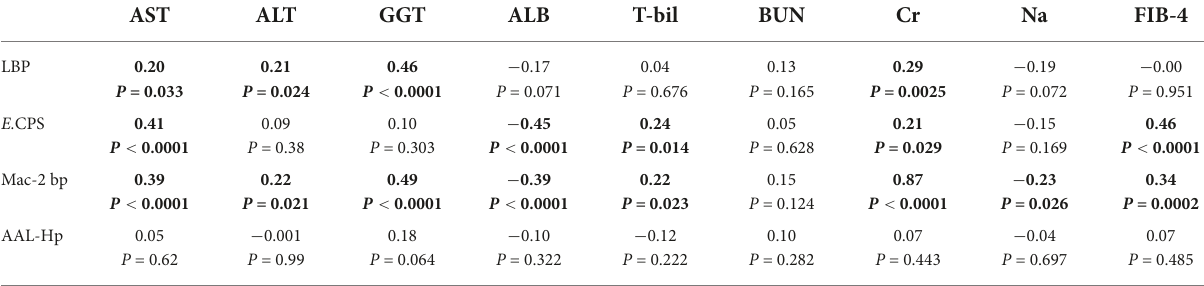
TABLE 2 Correlation of LBP, E. CPS, Mac-2 bp and AAL-Hp to clinical parameters in all patients.